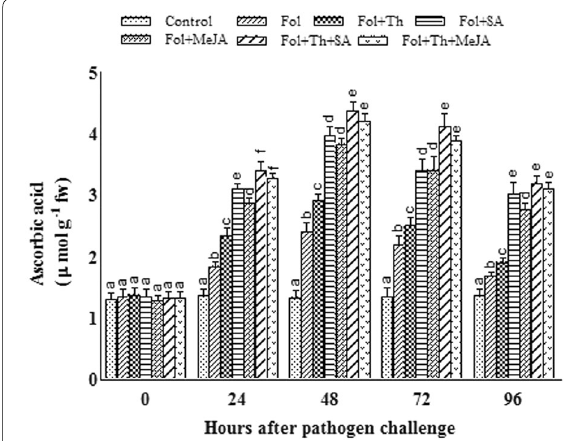
Fig. 4 Estimation of ascorbic acid in tomato plants pre-treated with T. harzianum , SA and MeJA either individually or in combination after challenge inoculation with Fusarium oxysporum f. sp. lycopersici (Fol). Results are expressed as the mean of three replicates and vertical bars indicate SD of the mean. Different letters indicate significant differ- ences among treatments within the results taken at the same time interval according to Duncan’s multiple range test at p